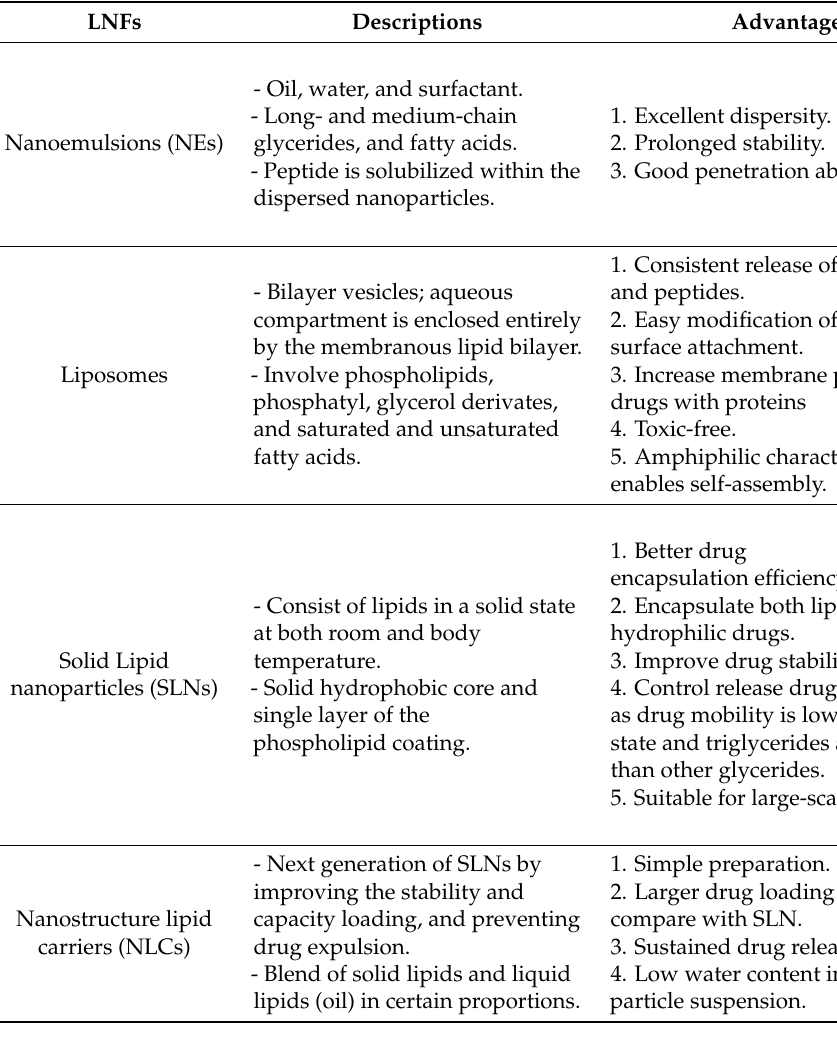
Table 2. Summary of different LNF types as peptide